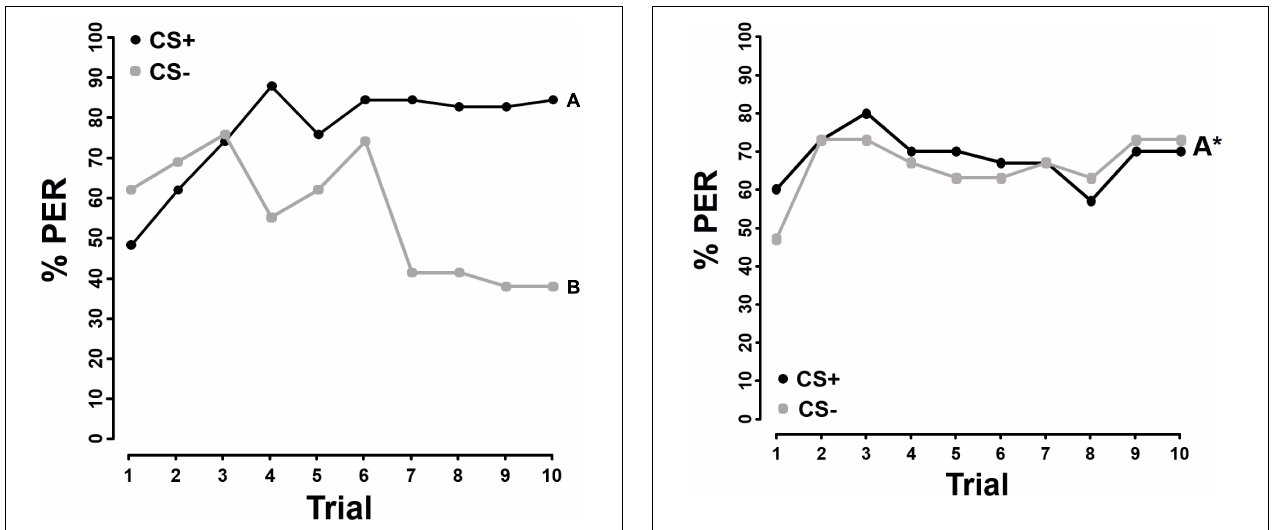
FIGURE 2 | Percentage of proboscis extension responses (% PER) shown by Apis mellifera individuals ( N = 58) in differential chemotactile conditioning to pollen enriched with 10x the natural fatty acid concentration (10x FA) against pure pollen ( N = 58) over 10 trials. CS+ (black) represents the rewarded conditioned stimulus, CS– (gray) the unrewarded conditioned stimulus. Both, 10x FA and pure pollen were used as CS+ and CS–. As there was no significant difference in learning performance between 10x FA and pure pollen used as CS+ or CS– ( Supplementary Table 4 ), data from both groups were combined. Different letters next to each line indicate a significant difference between the two stimuli ( P < 0.05).